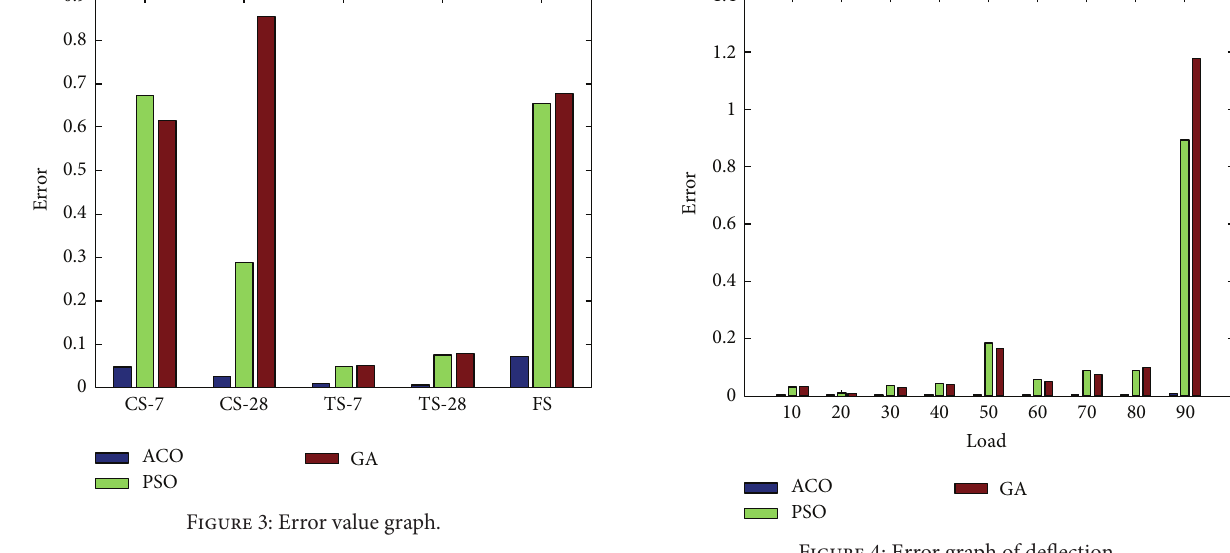
Figure 4: Error graph of deflection.